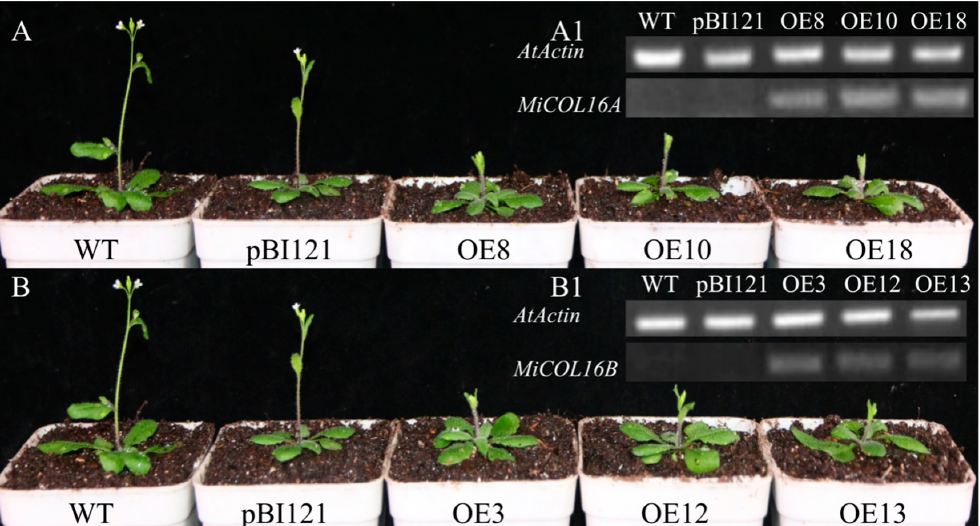
Table 1. Overexpression of MiCOL16A and MiCOL16B repressed flowering in Arabidopsis .